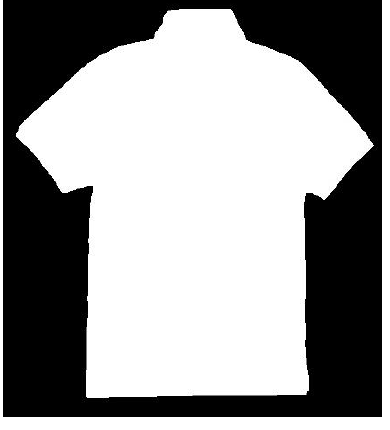
Figure 8. Invert filter result.